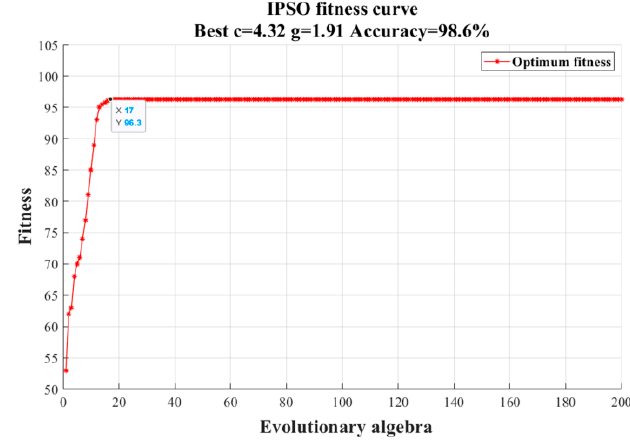
Figure 9. IPSO-SVM fitness curves in the model optimization.